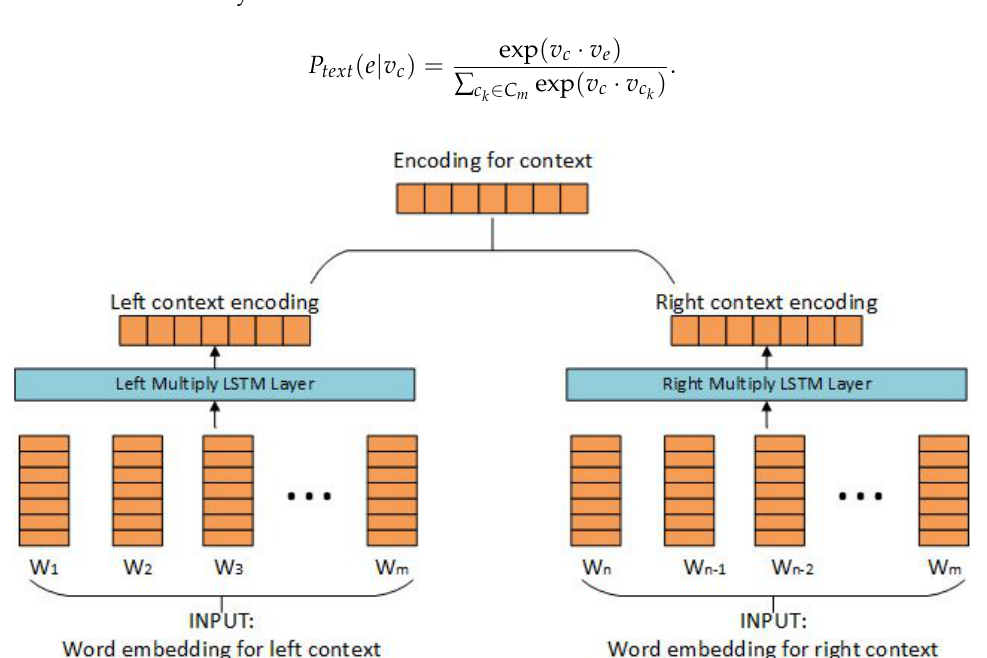
Figure 3. Encoding the entity context information with LSTM. The input of the model is word embeddings of the words in the context, which may come from an annotated corpus (e.g., Wikipedia hyperlinks in our